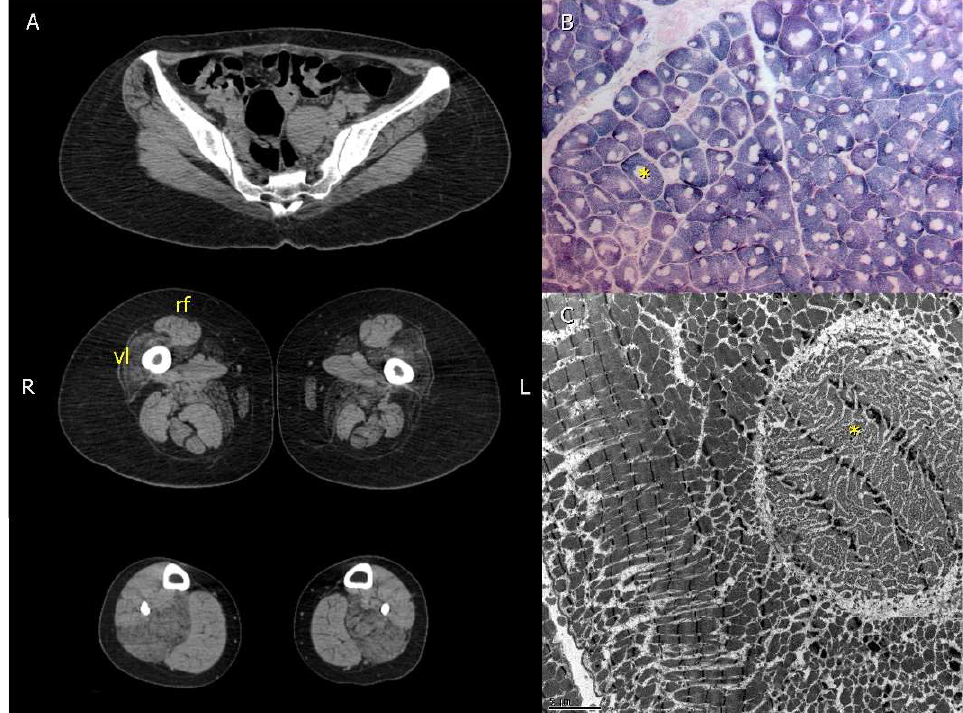
Figure 2. Imaging and muscle biopsy findings of patient 2.1 with the p.Gly4897Asp pathogenic variant in the RYR1 gene. ( A )—Computed tomography demonstrated severe right vastus lateralis (vl) muscle fat replacement with relative rectus femoris (rf) preservation. Computed tomography of the pelvis, thighs, and legs. ( B )—Muscle biopsy was performed in the rectus femoris demonstrating round core structures (*). SDH 100x. ( C )—Core areas (*) were ultrastructurally characterized by myofibrillar disorganization with scarce mitochondria. Transmission electron microscopy 2500×. This figure was modified from Cotta et al., 2021